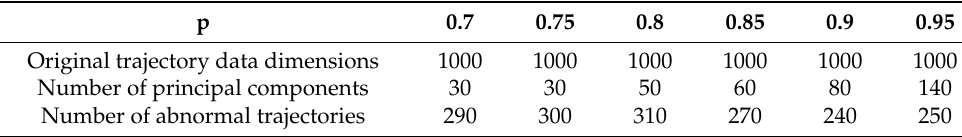
Figure 16. Trajectory displacement statistics. ( a ) The statistics of 7 targets; ( b ) the statistics of 21 targets; ( c ) the statistics of 35 targets. Table 1. Experimental result of extraction rate p ( ω = 8, v =